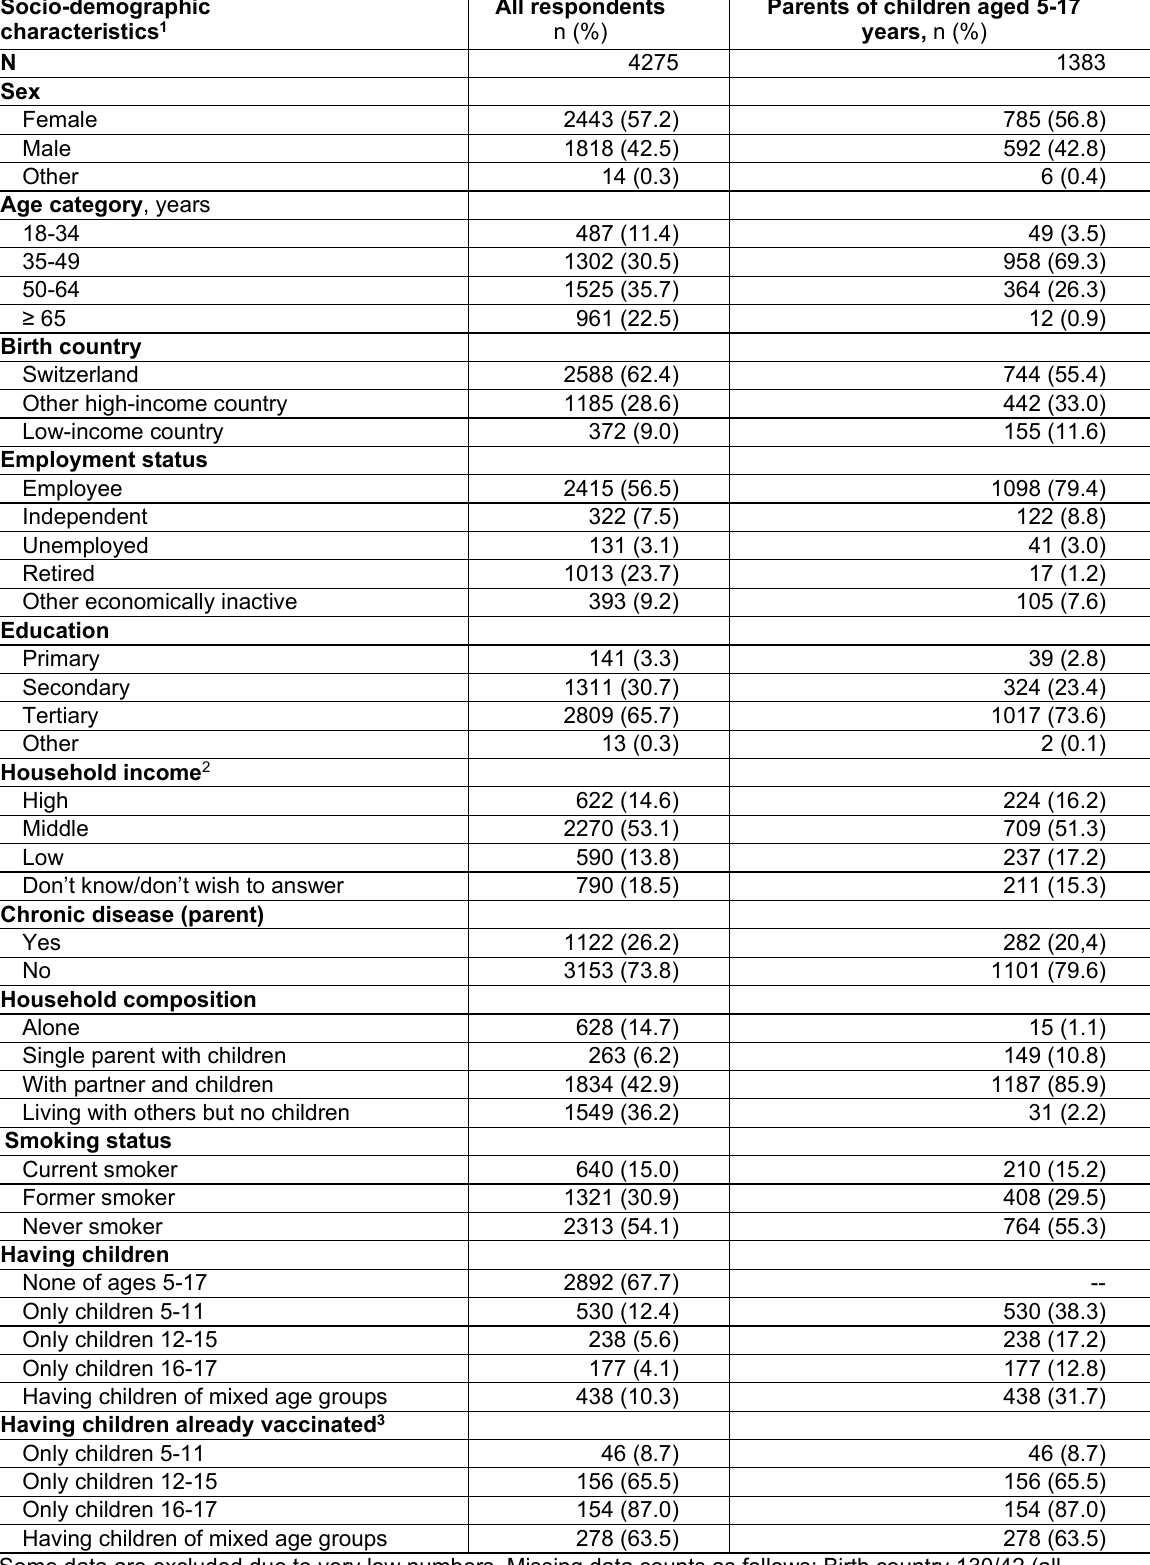
Supplementary table 2. Socio-demographic and health-related characteristics of the study participants